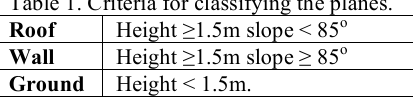
Fig. 6. Identified planes related to Fig. 5 right (red: roof, green: wall, blue: ground). Table 1. Criteria for classifying the planes.